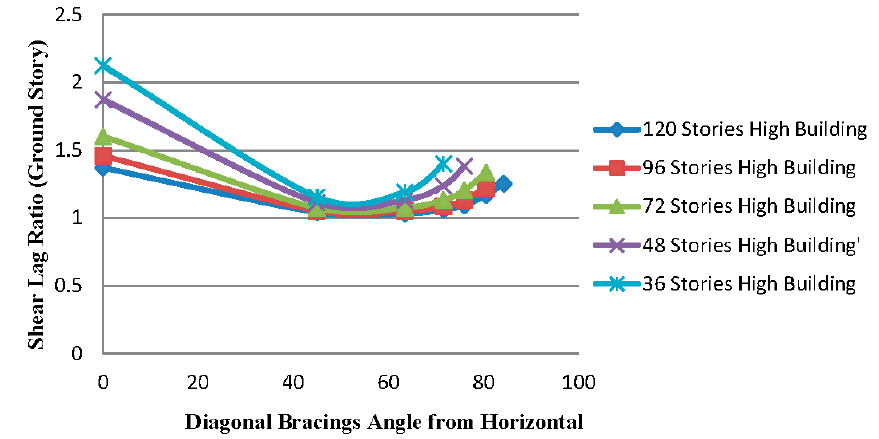
Figure 12. Variation of shear lag with varying angle of bracing system for buildings of Model